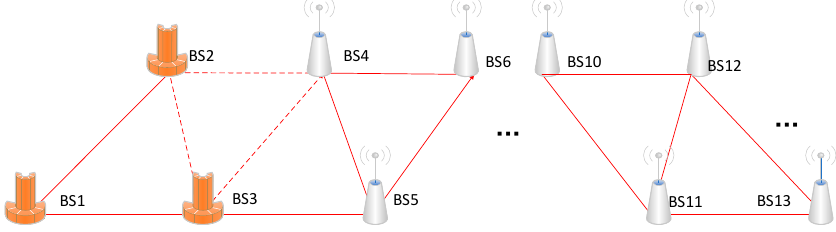
Figure 9. Virtual triangle transfer process in one segment.